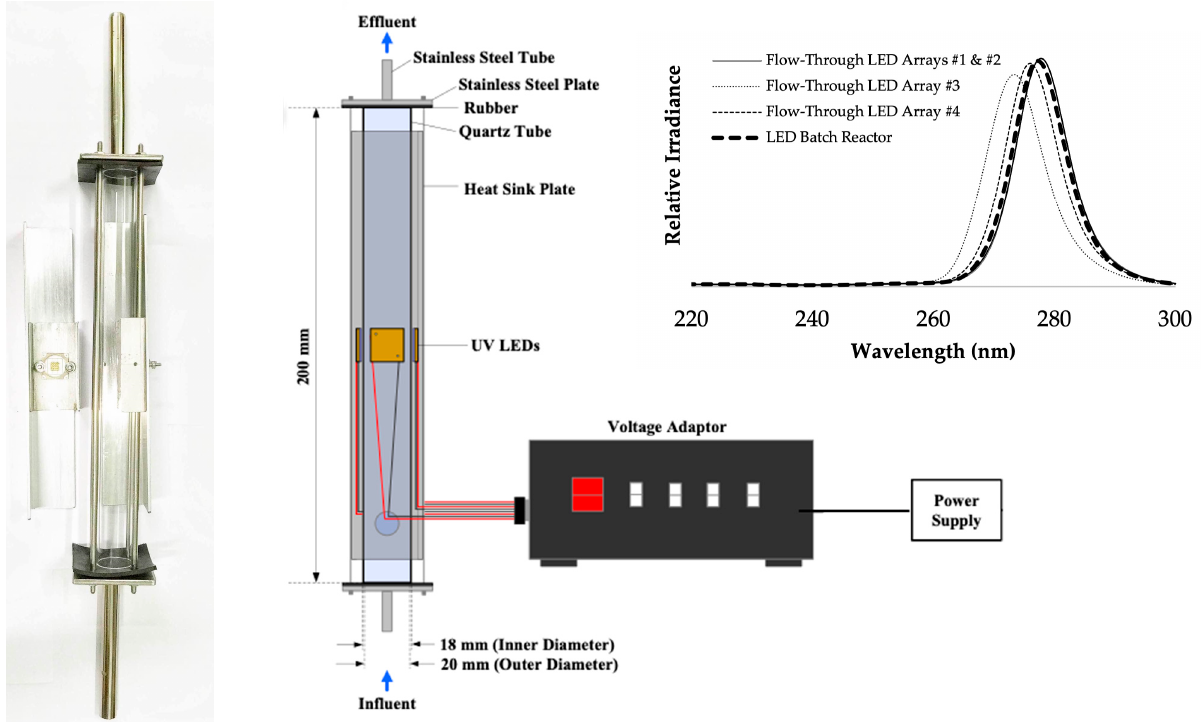
Figure 3. Photo, schematic, and emission spectra of the flow-through UV LED reactor constructed in Thailand. For both flow-through reactors, the UV-induced log reduction of MS2 was measured at each flow rate for each water matrix tested. In parallel, quasi-collimated beam experiments were conducted with a batch reactor to determine the dose response of the microorganism in each wastewater matrix. Given the log reduction of MS2, the dose response curves were then used as a standard curve to back-calculate the reduction equivalent dose (RED) delivered by the flow-through reactors at each flow rate. Multiple flow rates were used for each experiment, corresponding to multiple UV doses. To evaluate the disinfec- tion performance of the UV LEDs and the LP UV lamp for the flow-through reactors, the same wastewaters and septic tank samples spiked with MS2 were used for the batch tests